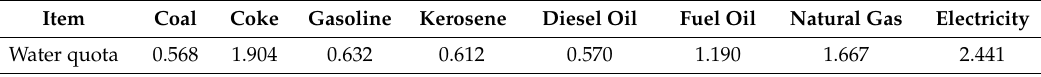
Table 2. Water quota for various energy processes (m 3